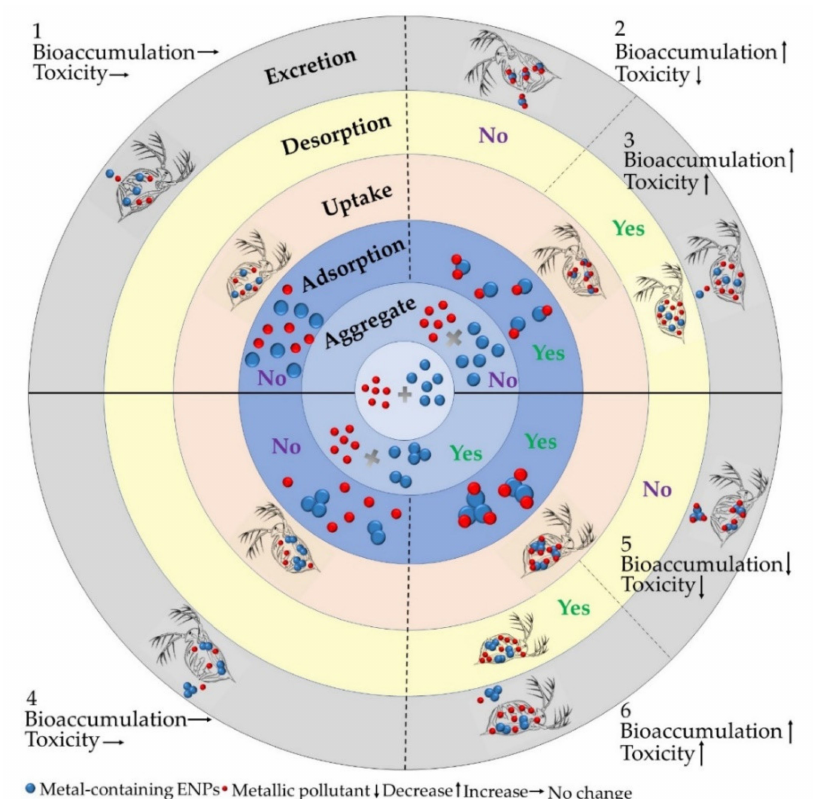
Figure 3. Conceptual presentation of di ff erent scenarios concerning combined e ff ects of mixtures of ENPs and metallic pollutants to ecologically important freshwater zooplankton species Daphnia magna